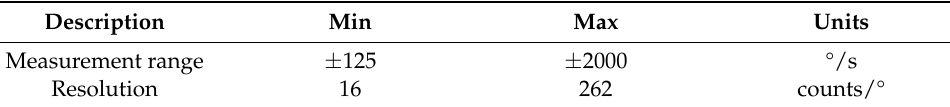
Table 3. Gyroscope technical